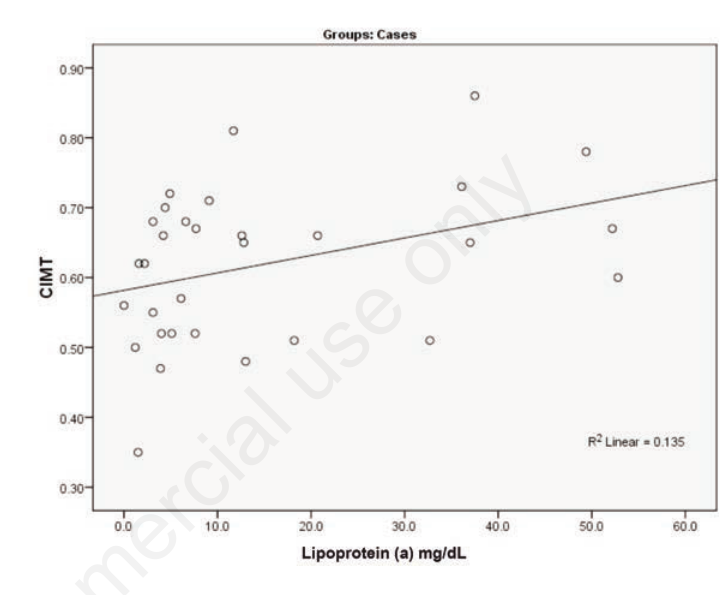
Figure 2. Correlation of carotid intima-media thickness (CIMT) with lipoprotein (a).